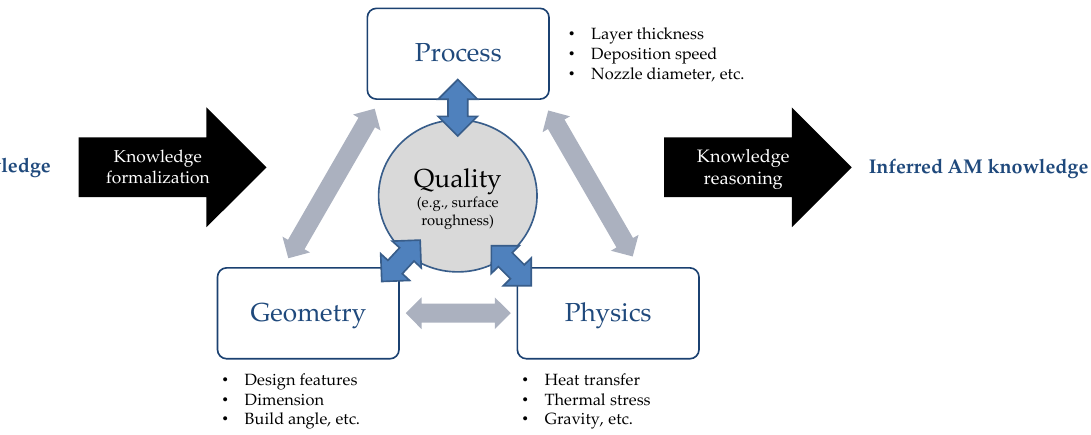
Figure 2. Relationships among process, physics, geometry, and surface roughness.